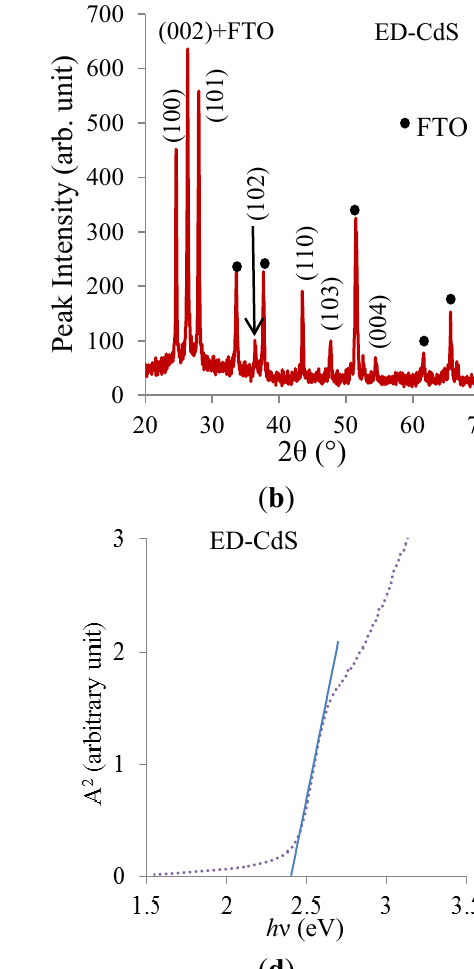
Figure 14. ( a , b ) XRD, ( c , d ) optical absorption and ( e , f ) SEM results of ( a , c , e ) heat-treated cubic chemical bath deposited (CBD)-CdS and ( b , d , f ) hexagonal electrodeposited (ED)-CdS layers used in CdS/CdTe solar